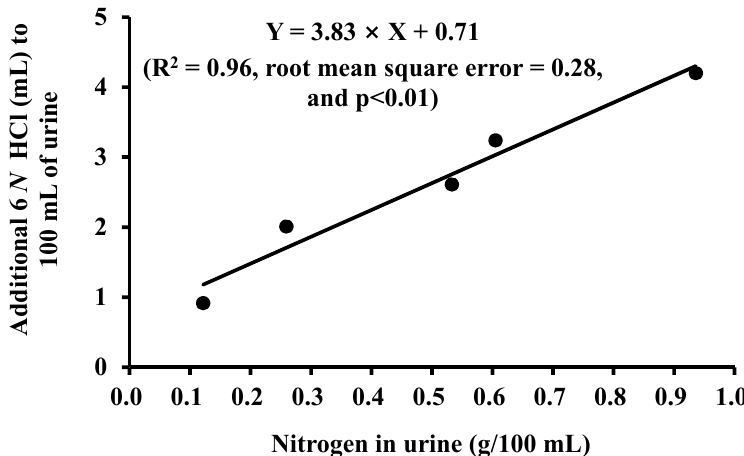
Y = 3.83 × X + 0.71 (R 2 = 0.96, root mean square error = 0.28, and p<0.01)